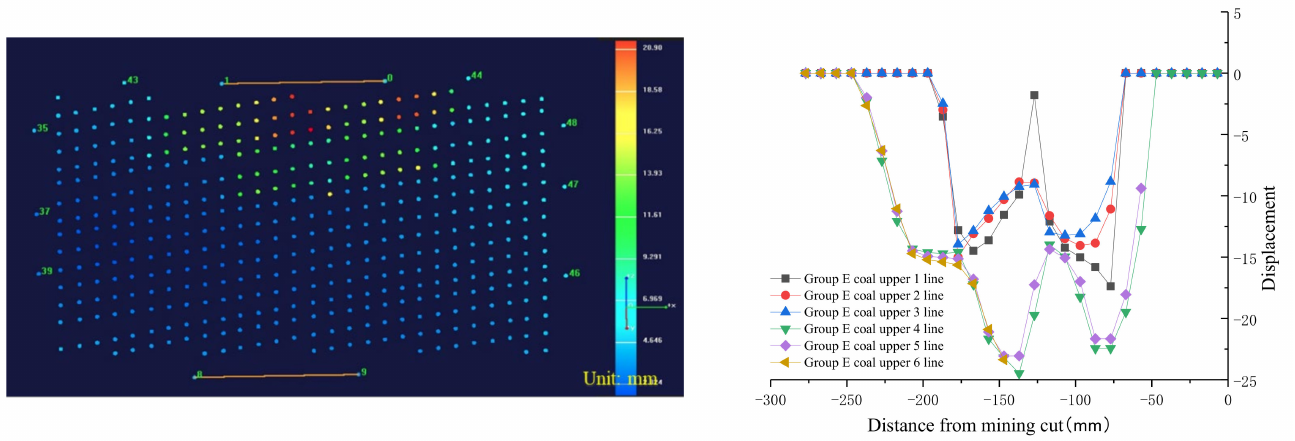
Figure 6. Drawing of roof caving and displacement in mining of Group E coal